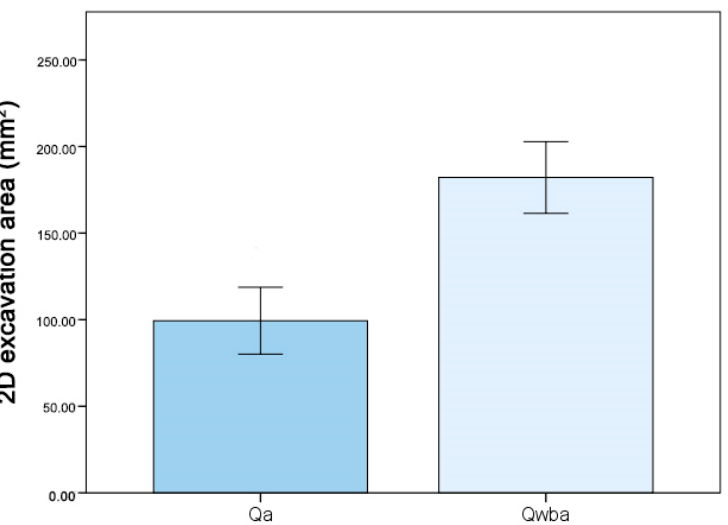
Figure 8. Two-dimensional excavation area (mm 2 ) of the ant chamber in experimental galls of C. scutellaris containing aphids ( P. juglandis ). Qa = queen only + aphids; Qwba = C. scutellaris queen + workers + brood + aphids. SE interval is shown for each bar. The bars with the same letter are not statistically different (one-way ANOVA, Tukey’s post-hoc tests).